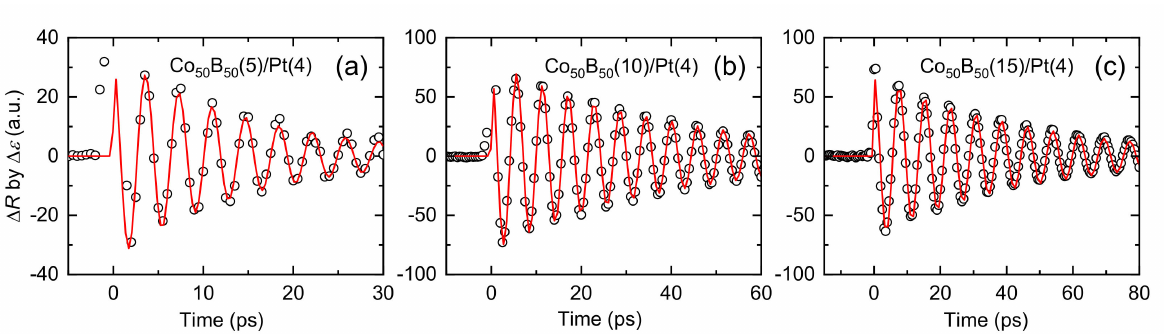
Figure 4. Acoustic oscillation. The extracted acoustic oscillation of the ( a ) sap/Co 50 B 50 (5 nm)/Pt (4 nm), ( b ) sap/Co 50 B 50 (10 nm)/Pt (4 nm), and ( c ) sap/Co 50 B 50 (15 nm)/Pt (4 nm) samples. The black circles are data, and the red lines are fittings with a damped cosine function of A cos ( 2 π ft ) exp ( − t / τ ) . The fitted f and τ : ( a ) f = 270 GHz, τ = 15 ps; ( b ) f = 174 GHz, τ = 40 ps; ( c ) f = 129 GHz, τ = 45